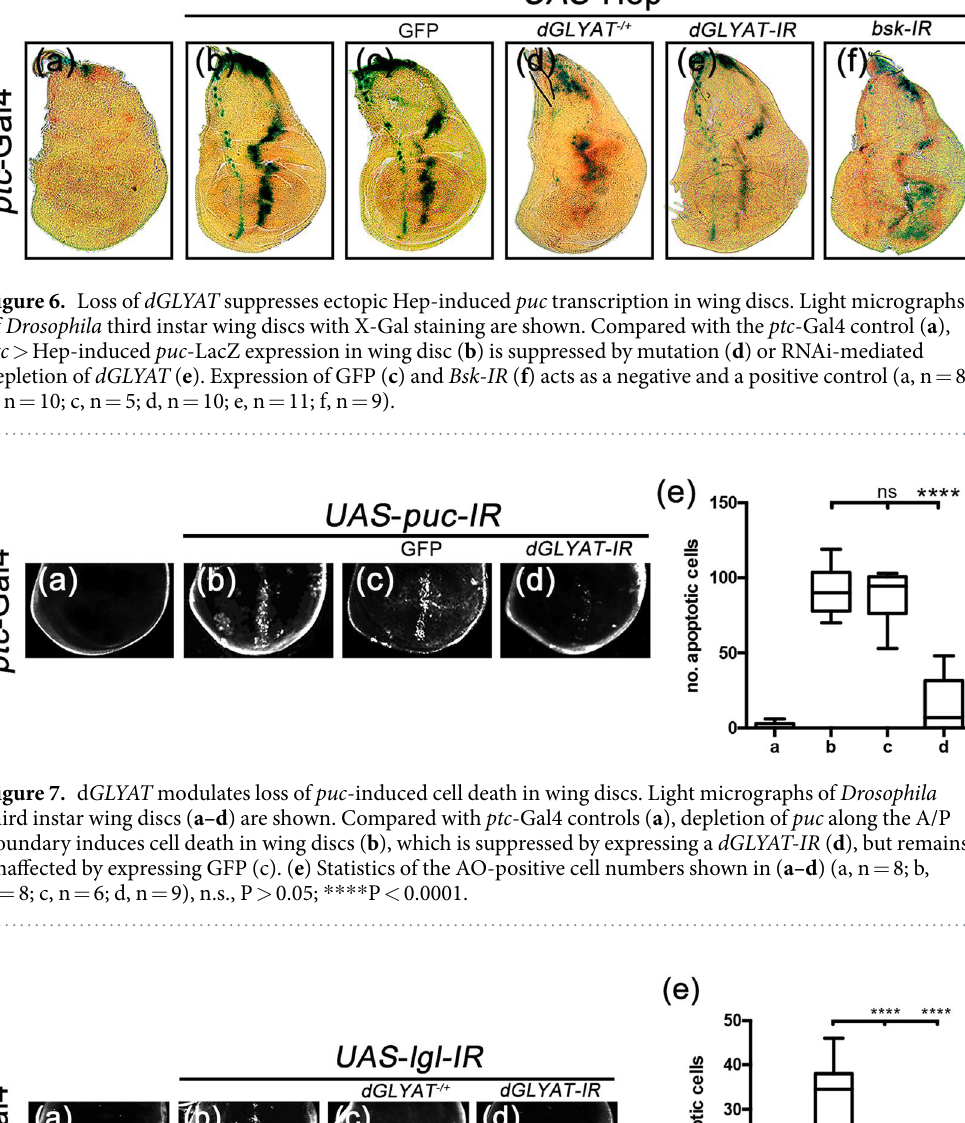
6 Scientific RepoRts | 7: 5183 | DOI:10.1038/s41598-017-05482-y